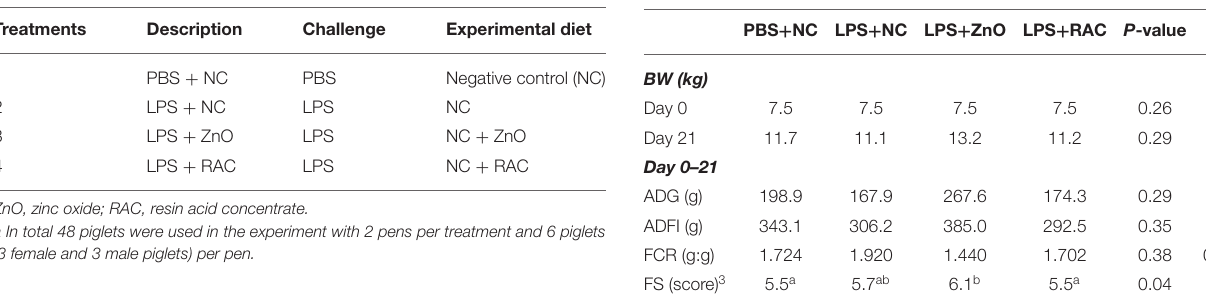
TABLE 2 | Effect of experimental treatments on piglet performance 1